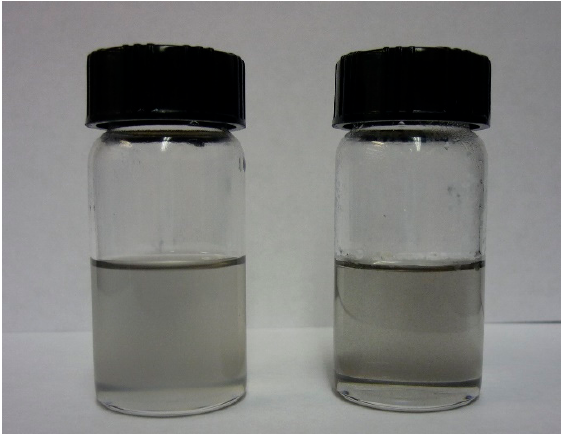
Figure 9. Dispersion of pristine SWNTs and SWNTs- g -PS in THF (left photo) and in CHCl 3 (right photo) at room temperature (0.3 mg mL − 1 ).